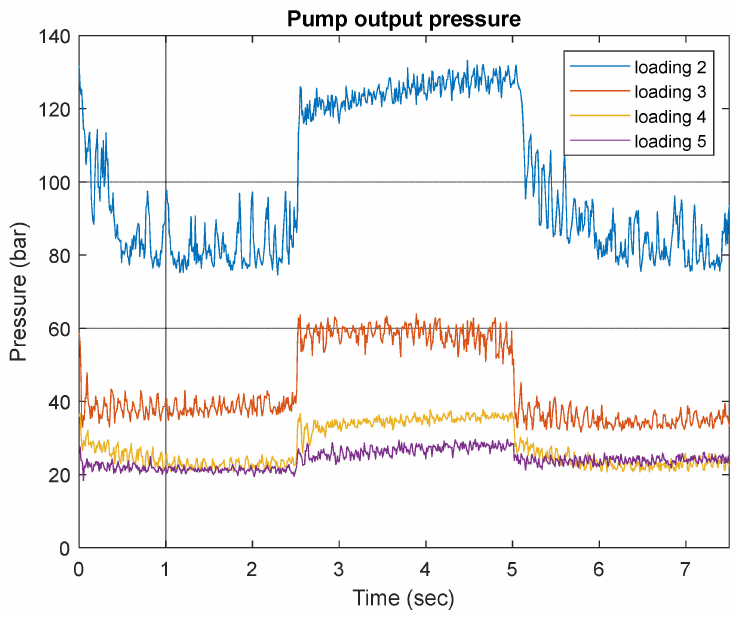
Figure 20. Measured pump output